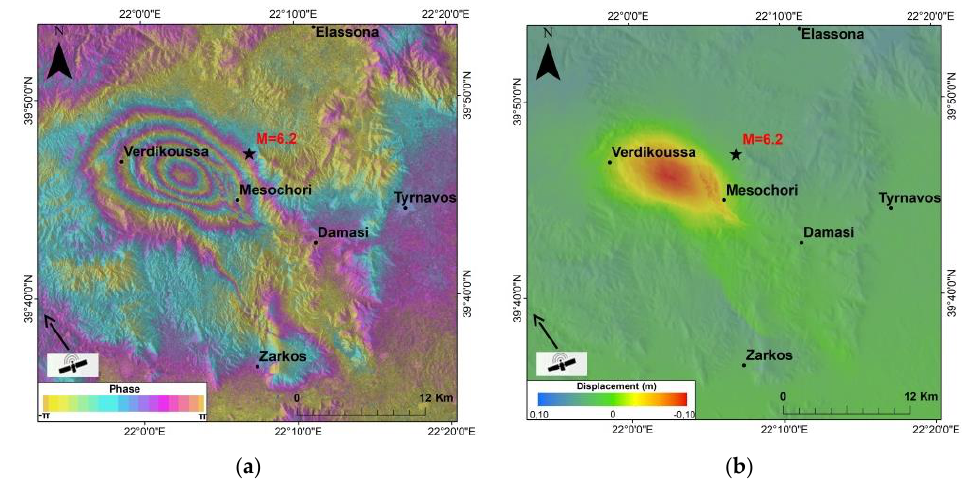
Figure 12. ( a ) Wrapped interferogram and ( b ) LoS displacement for the second seismic event of 4 March 2021 from master and slave images taken in ascending mode on 3 March 2021 and 9 March 2021, respectively; star shows relocated epicenter .